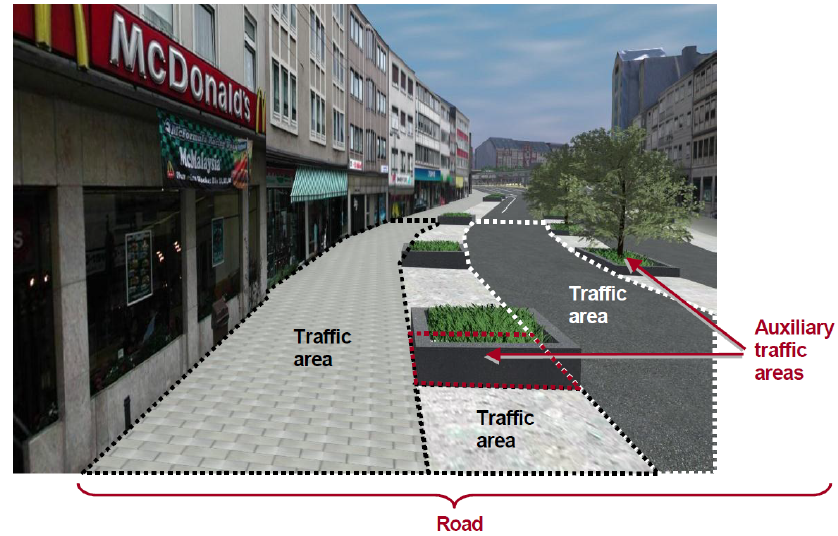
Figure 6. Example of a road (space) in LOD2 in CityGML,which is the aggregation of traffic areas and auxiliary traffic areas